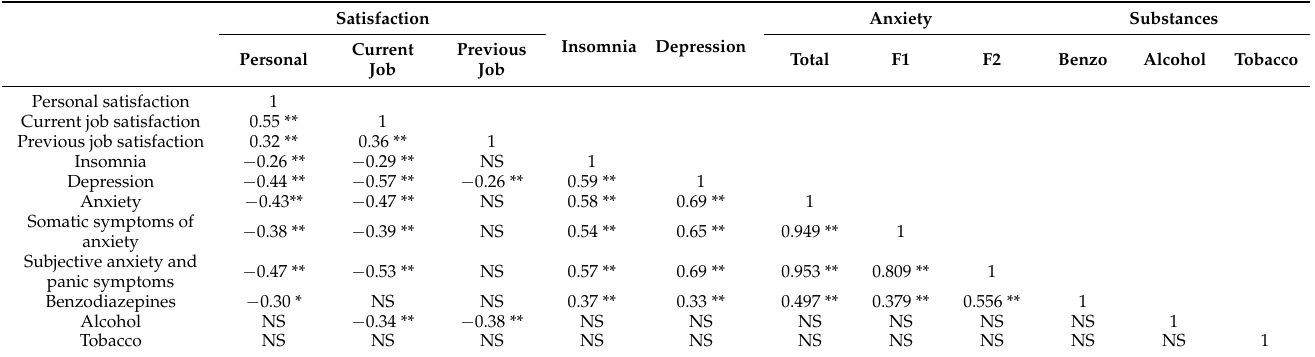
Table 11. Bivariate correlations using Pearson’s correlation coefficient.